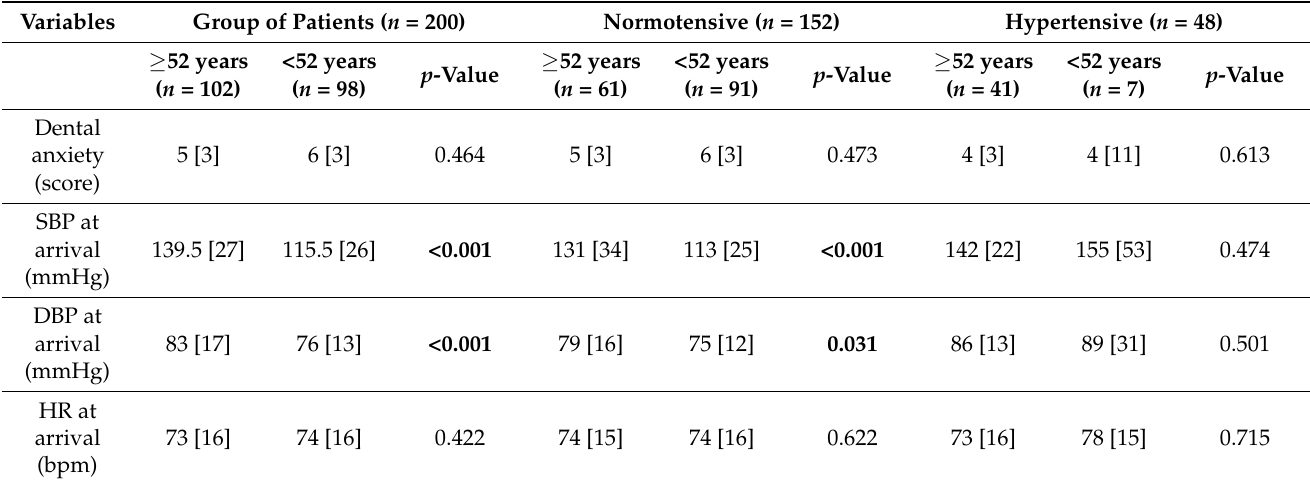
Table 5. Comparisons of study variables by age (Median